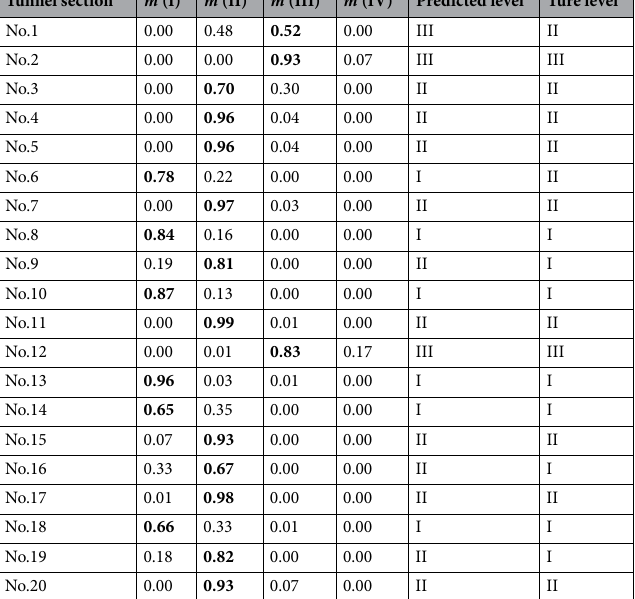
Table 3. Results of Bayesian network at ten monitoring sections. Significant values are in bold.